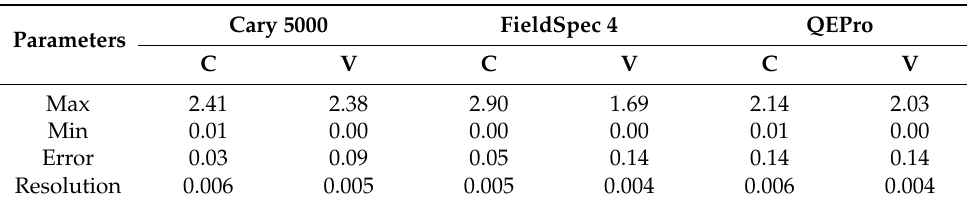
Table 3. The parameters to evaluate spectral models in both calibration set (C) and validation set (V),